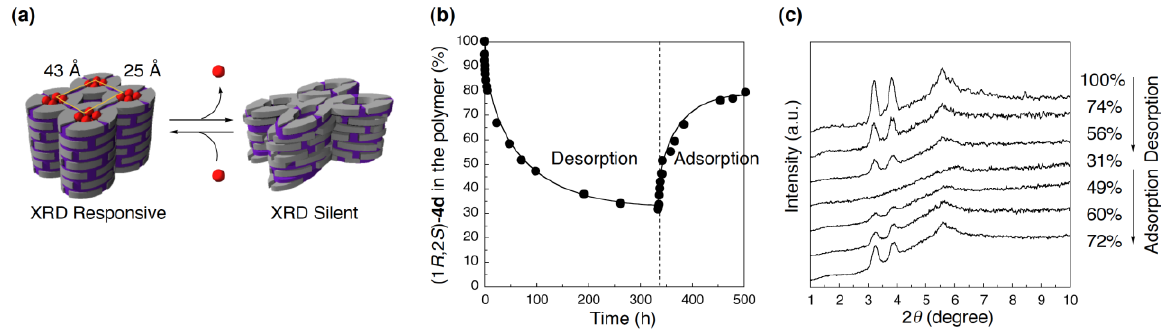
Figure 7. Desorption/adsorption of the template (1 R ,2 S )- 4d from/to the cross-linked polymer: ( a ) Schematic representation of the structural switching; ( b ) Time course of